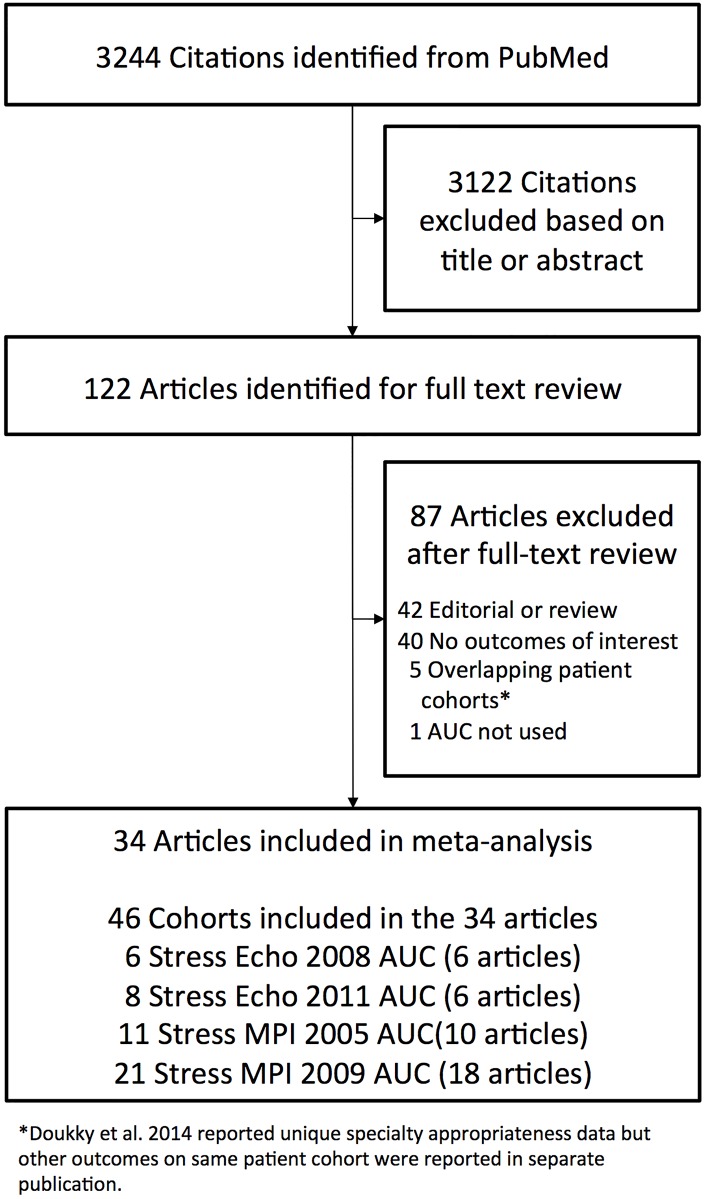
Flow Diagram of the Literature Search and Study Selection.